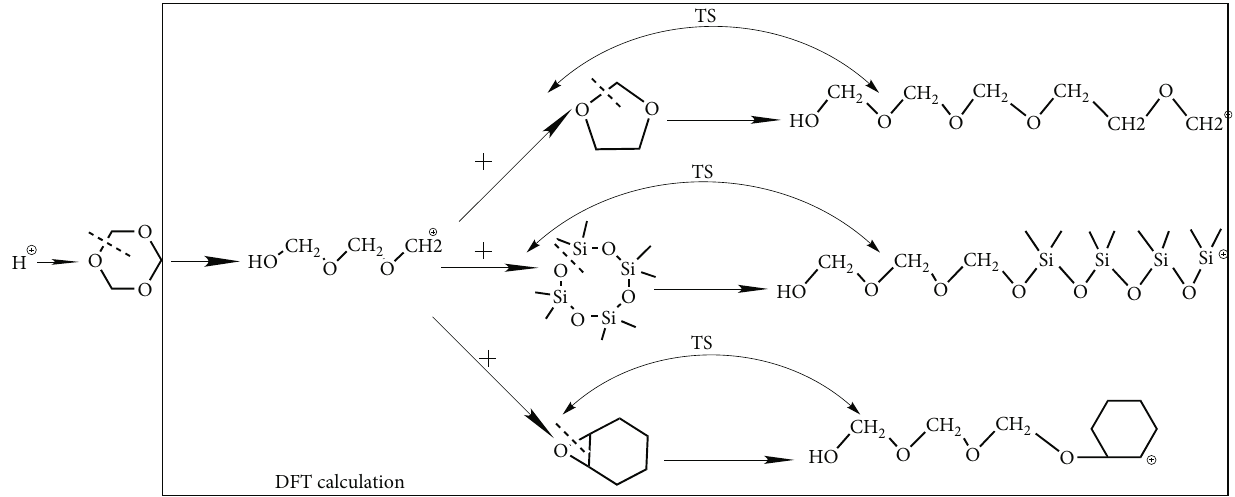
Scheme 2: The section of the DFT calculation of copolymerization of the second monomer with